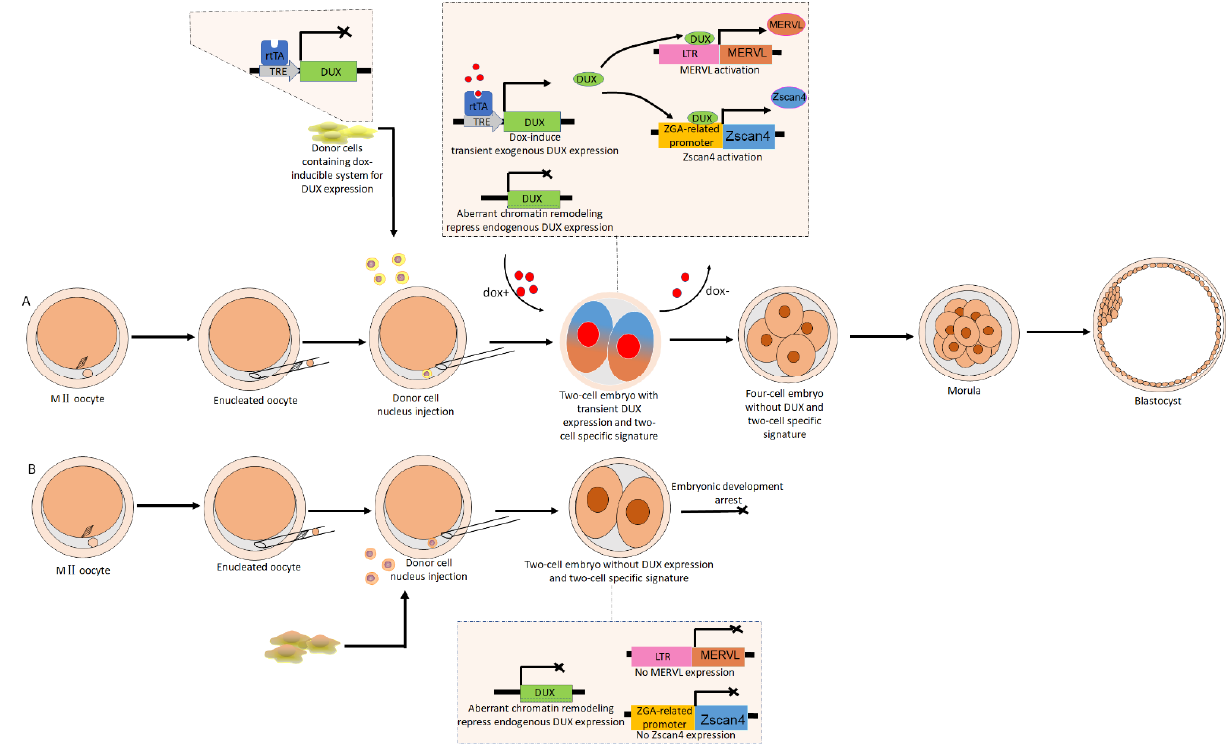
Figure 1. Schematic illustration showing how to induce the transient expression of exogenous double homeobox (DUX) via a dox-inducible system in cloned embryos. ( A ) Somatic cell nuclear transfer (SCNT) was performed with donor somatic cells that contained a dox-inducible system. The dox was supplied during the time window from late one-cell stage to early two-cell stage by switching between dox-containing and dox-free culture medium. With dox treatment, reverse tet-transactivator (rtTA) is activated, then DUX, controlled by tetracycline-regulated element (TRE), is expressed. Although the expression of endogenous DUX was still not initiated, owing to the aberrant chromatin remodeling in cloned embryos, the exogenous DUX was transiently expressed, and DUX activated murine endogenous retrovirus (MERVL) and Zscan4 via binding to long terminal repeat (LTR) or ZGA-related promoter, allowing the embryo to ultimately overcome its developmental arrest. Owing to the withdrawal of dox, the four-cell embryo, which lacks DUX and normal two-cell signatures, continued its own development and reached the blastocyst stage. ( B ) SCNT was performed with donor somatic cells that lacked a dox-inducible system. When the cloned embryo developed to the two-cell stage, endogenous DUX was not initiated due to the aberrant chromatin remodeling in cloned embryos, and neither MERVL nor Zscan4 were activated. The cloned embryo was arrested at the two-cell stage.